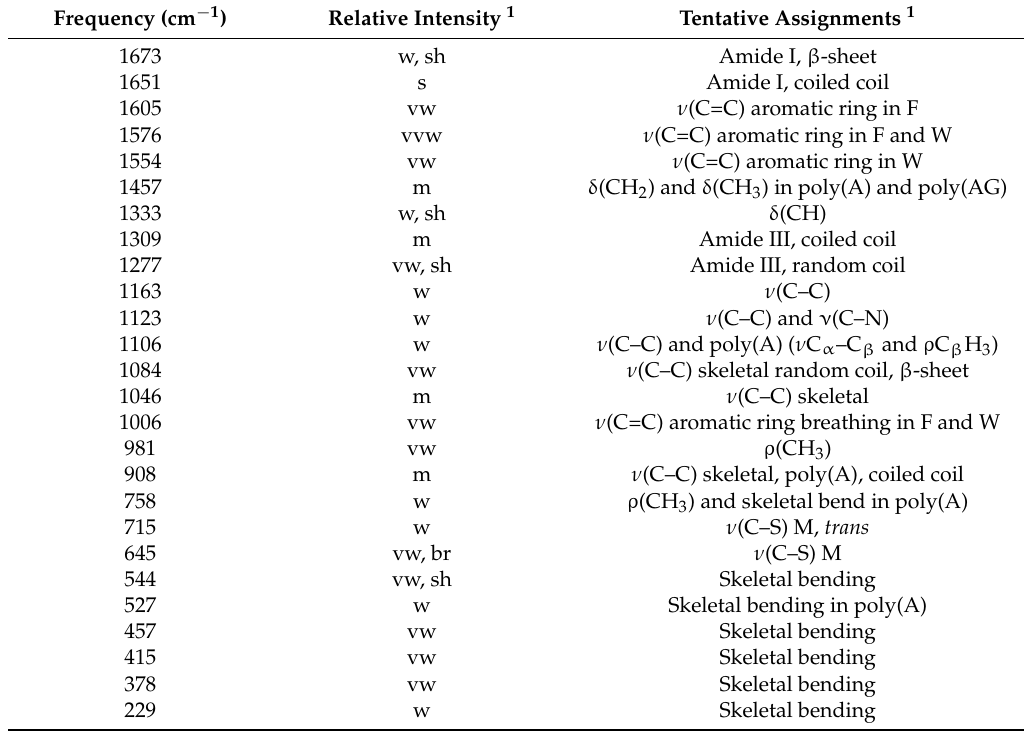
Table 1. Raman bands and their tentative assignments for the hand drawn B. terrestris silk fibre. Frequency (cm ´ 1